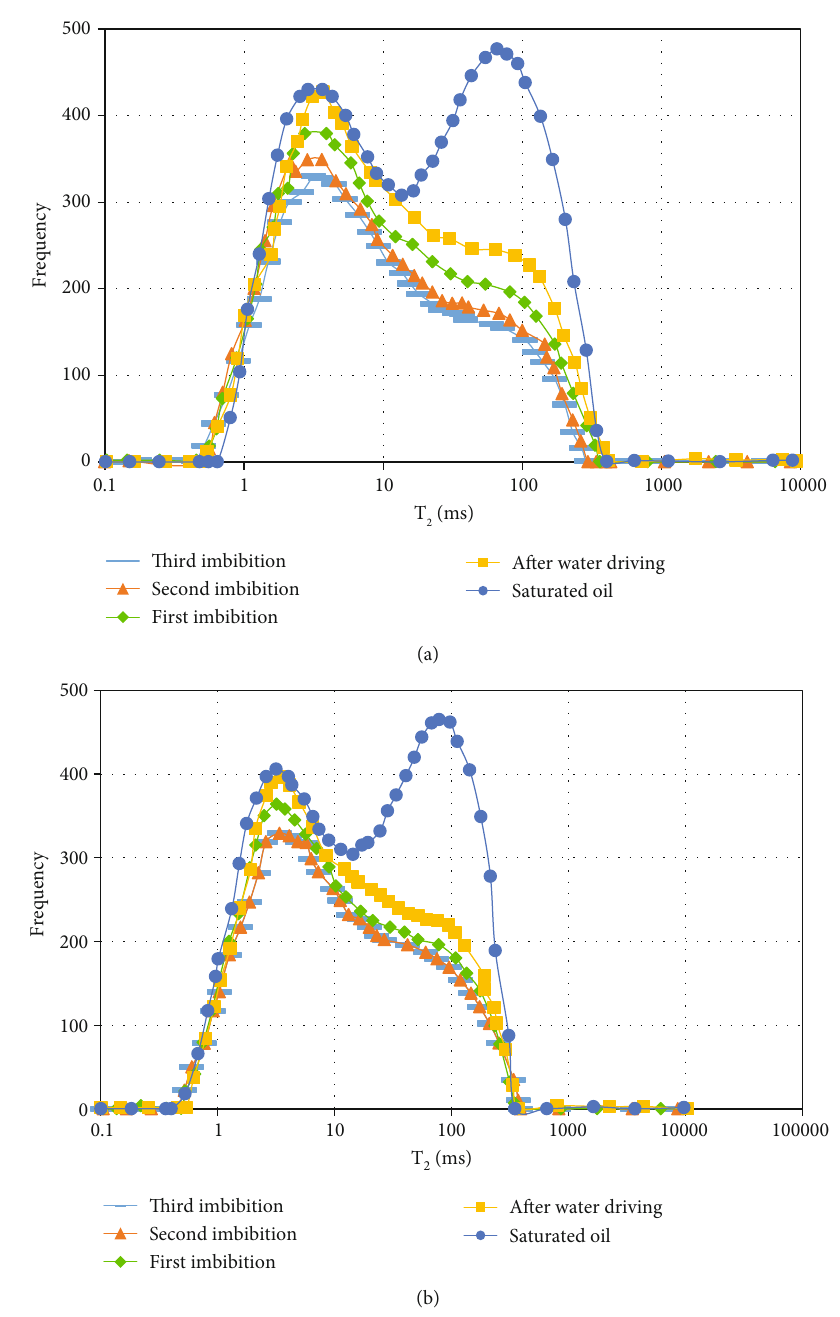
Figure 11: NMR results of (a) 2-2 (no fracture) and (b) 2-12 (with